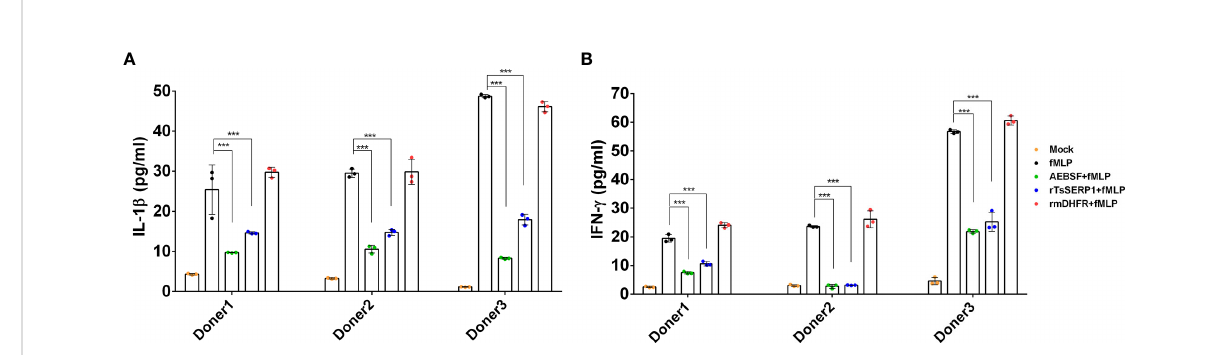
FIGURE 6 Inhibitory effect of rTsSERP1 on the production of proin fl ammatory cytokines released by human neutrophils. In addition to determining the transcription levels of cytokine and chemokine mRNAs in neutrophils, culture media were also collected for ELISA to analyze IL-1 b (A) and IFN- g (B) protein levels. ELISA results are reported as pg/ml. The bar charts show the data of three different donors, which are presented as the mean ± SD. The experiments were performed in triplicate with three independent experiments. One-way ANOVA followed by a Bonferroni multiple comparison test were used for statistical analysis: *** p < 0.001. The treatment conditions were included media alone (Mock), only fMLP induction (fMLP), fMLP induction and AEBSF treatment (AEBSF+fMLP), fMLP induction and rTsSERP1 treatment (rTsSERP1+fMLP), fMLP induction and irrelevant control (rmDHFR) treatment